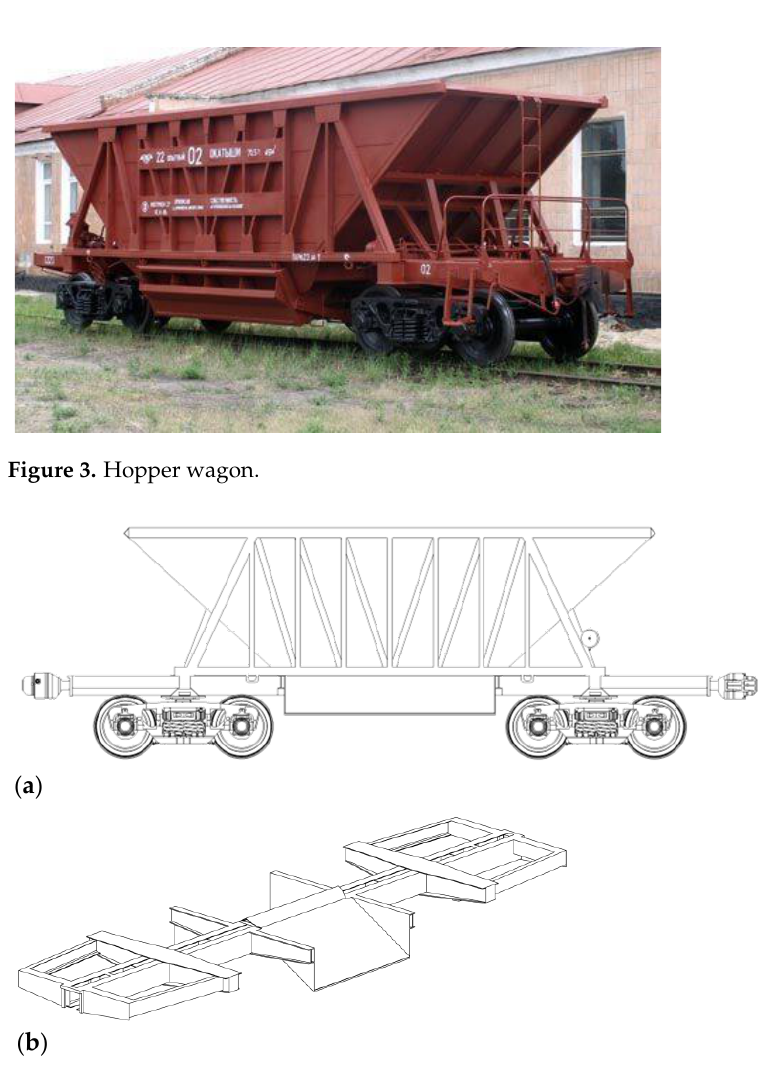
Figure 4. Finite element model of the hopper wagon frame: ( a ) — general view; ( b ) — frame.